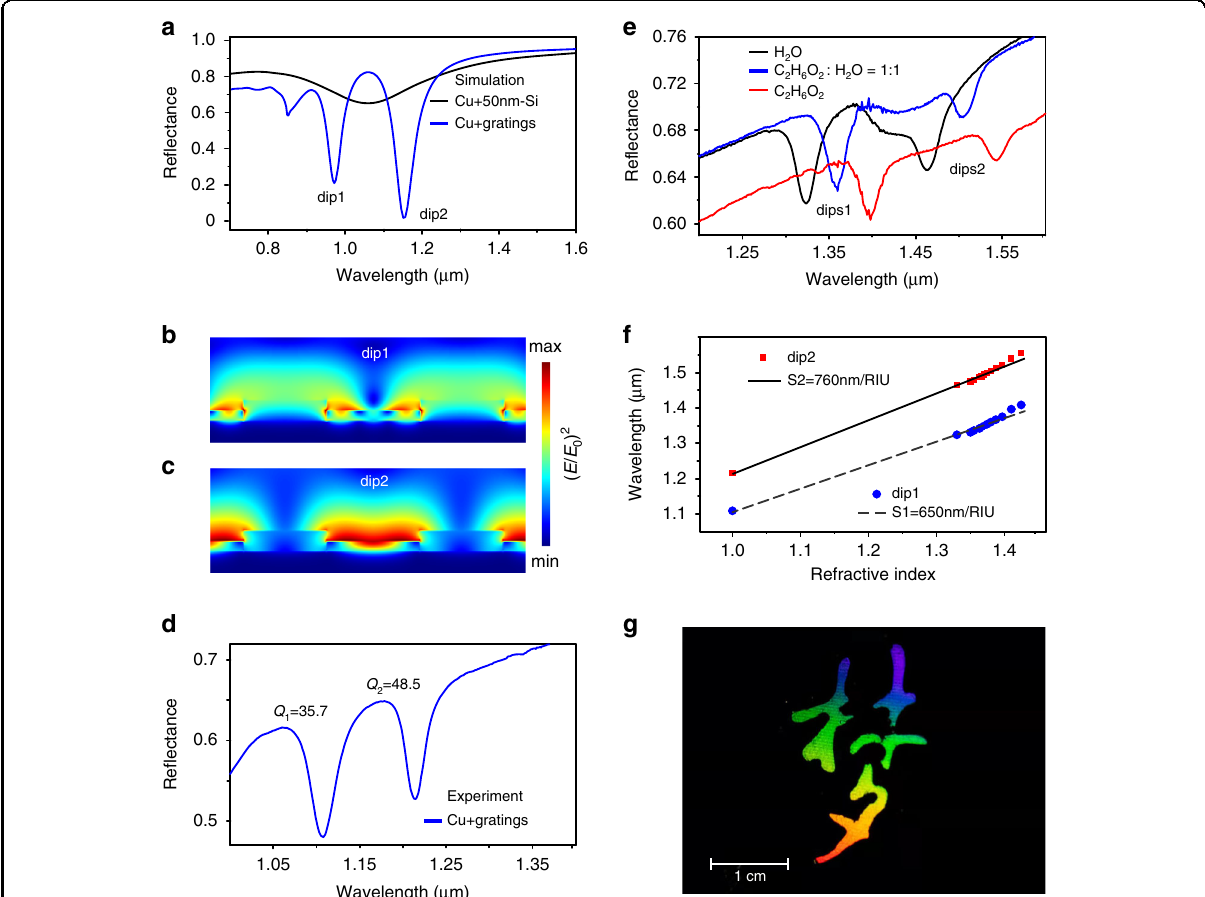
Fig. 4 Applications of wafer-scale nanogratings in refractive index sensing and structural coloring. In applications, copper is used instead of silver because of its lower cost. a Numerically simulated re fl ection spectrum of a pristine thin- fi lm absorber consisting of 50-nm-thick Si on 100-nm- thick Cu fi lm, and re fl ectance of a one-dimensional thin- fi lm grating. The grating periodicity is set to 900 nm, including 450-nm-width of Si and 450-nm-width SiO 2 . b , c The cross-sectional electric fi eld distribution at the two observed dips. Experimentally measured re fl ection spectra of a laser- produced nanograting on Cu fi lm in air ( d ) and in liquid environments ( e ). f Measured spectra dips versus refractive index of the involved liquids. g A photograph showing a colorful artistic word meaning “ dream ” that is written by femtosecond laser on SOM thin fi